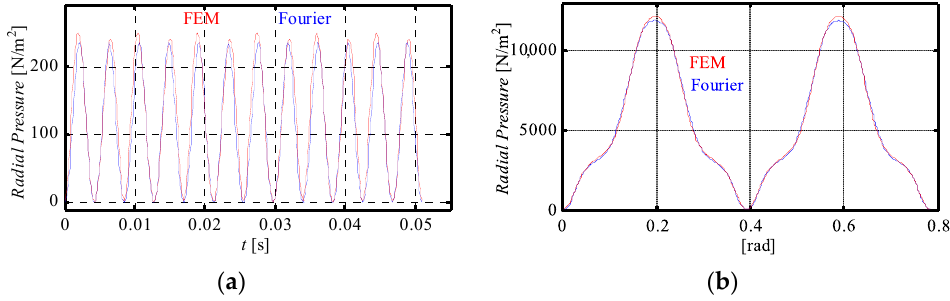
Figure 12. Magnetic pressure distribution created by stator coils on the rotor surface of the Qs48p8 machine: ( a ) temporal, ( b ) spatial.